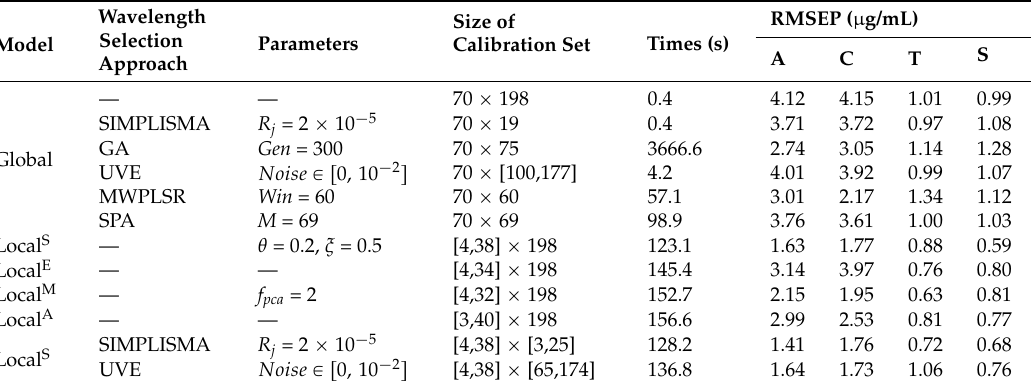
Table 4. Prediction results obtained using four methods.